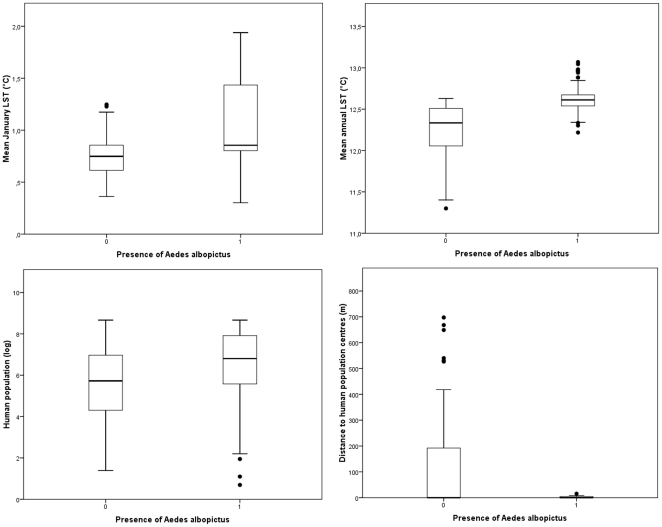
Differences between the areas with/without Ae. albopictus presence and the four explanatory variables: JanTmean LST (top left), AnnTmean LST (top right), human population density (log) (bottom left) and distance to human population centers (bottom right).